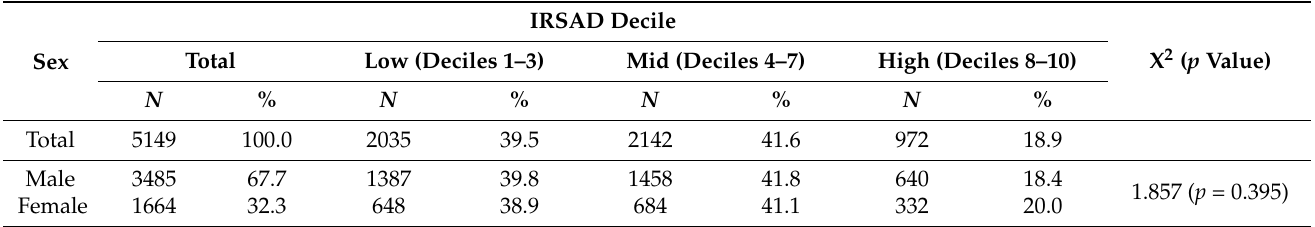
Table 6. Injury-related fatalities by sex and index of relative socio-economic advantage and disadvantage decile (IRSAD), Australia, 2007-08 to 2016-17.